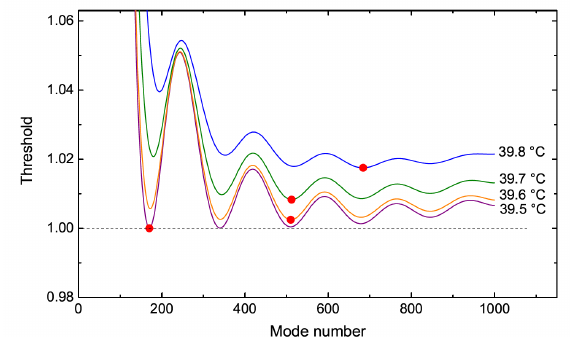
Figure 12: Linear stability analysis. Power threshold as a function of the number mode µ for different temperatures around the SHG phase matching temperature. Red dots indicate the lowest values for each